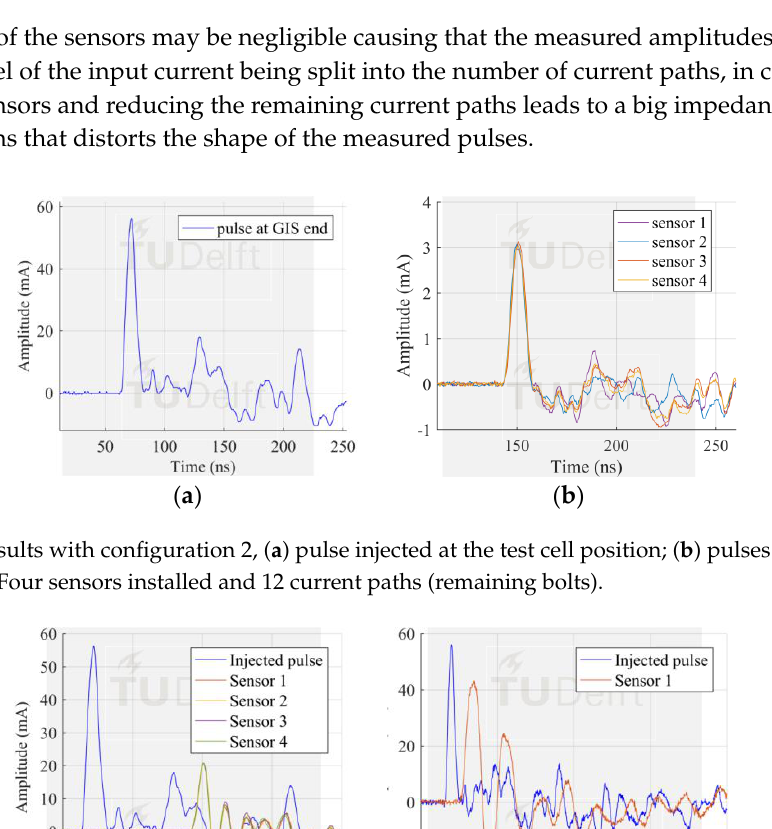
Figure 5. Results with configuration 1, ( a ) pulse injected at the test cell position; ( b ) pulse measured by HFCT 1. Only one sensor installed and 15 parallel current paths.